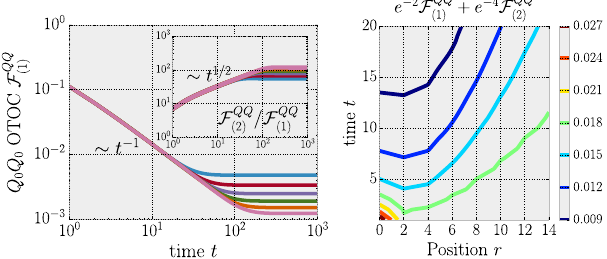
ˆ Q ˆ Q 0 0 ffiffi p t and saturates to an O ð L Þ ˆ Q ˆ Q OTOC truncated